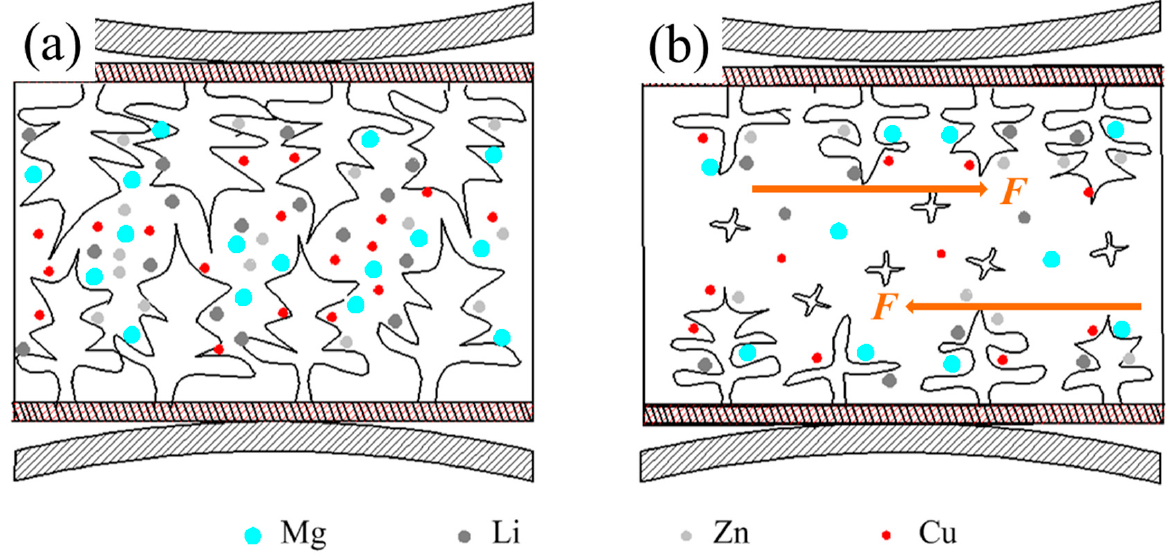
Figure 12. The action model of electromagnetic body force in the cast-rolling zone: ( a ) TRC; ( b ) electromagnetic TRC.